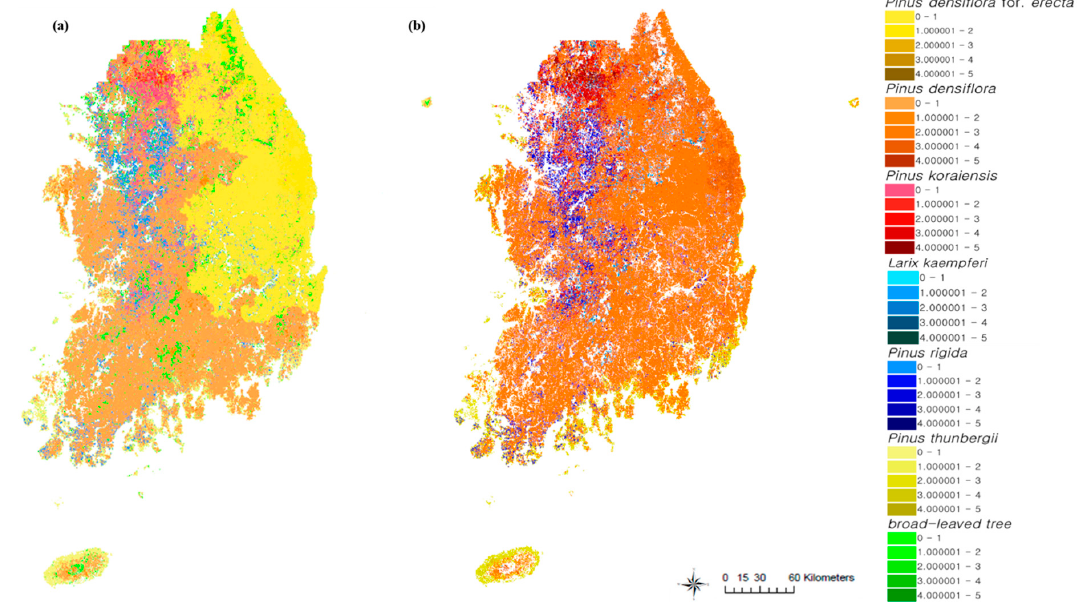
Figure 2. Distribution of ( a ) surface- and ( b ) crown-fire carrying fuels (kg/m 2 ) in Korea.